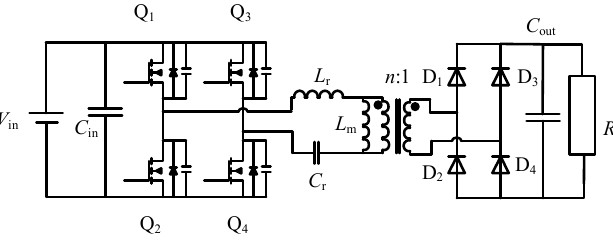
Figure 1. LLC resonant converter circuit diagram.